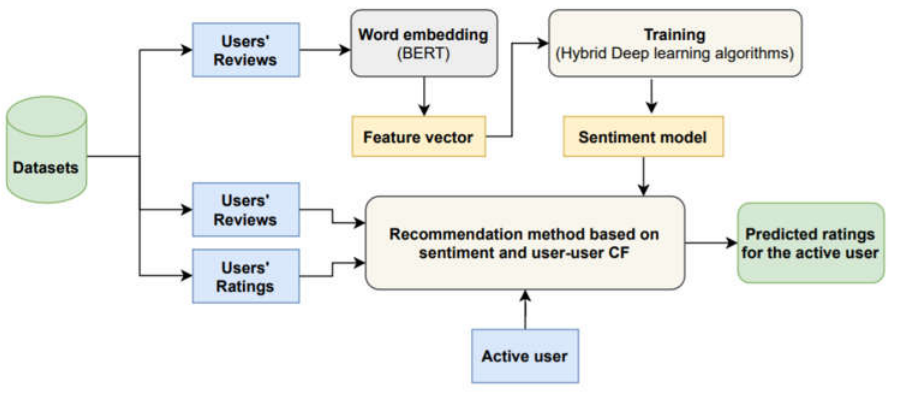
Figure 3. An architecture application in a recommender system.